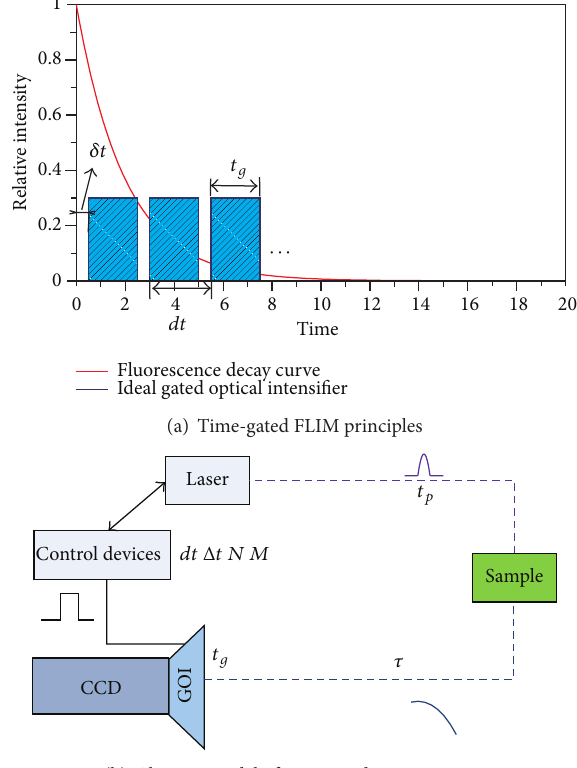
Figure 1: Abstract system model and temporal parameters. ( 𝑡 𝑝 shows laser pulse, 𝜏 stands for sample lifetime, and 𝑡 𝑔 means gate width of gated optical intensifier (GOI), 𝑁 , 𝑑𝑡 , Δ𝑡 , 𝑀 and 𝛿𝑡 represent number of gates opened in one excitation, gate interval of 𝑁 gates, delay step of different excitations, number of excitations, and the interval between laser excitation and opening of the first gate,